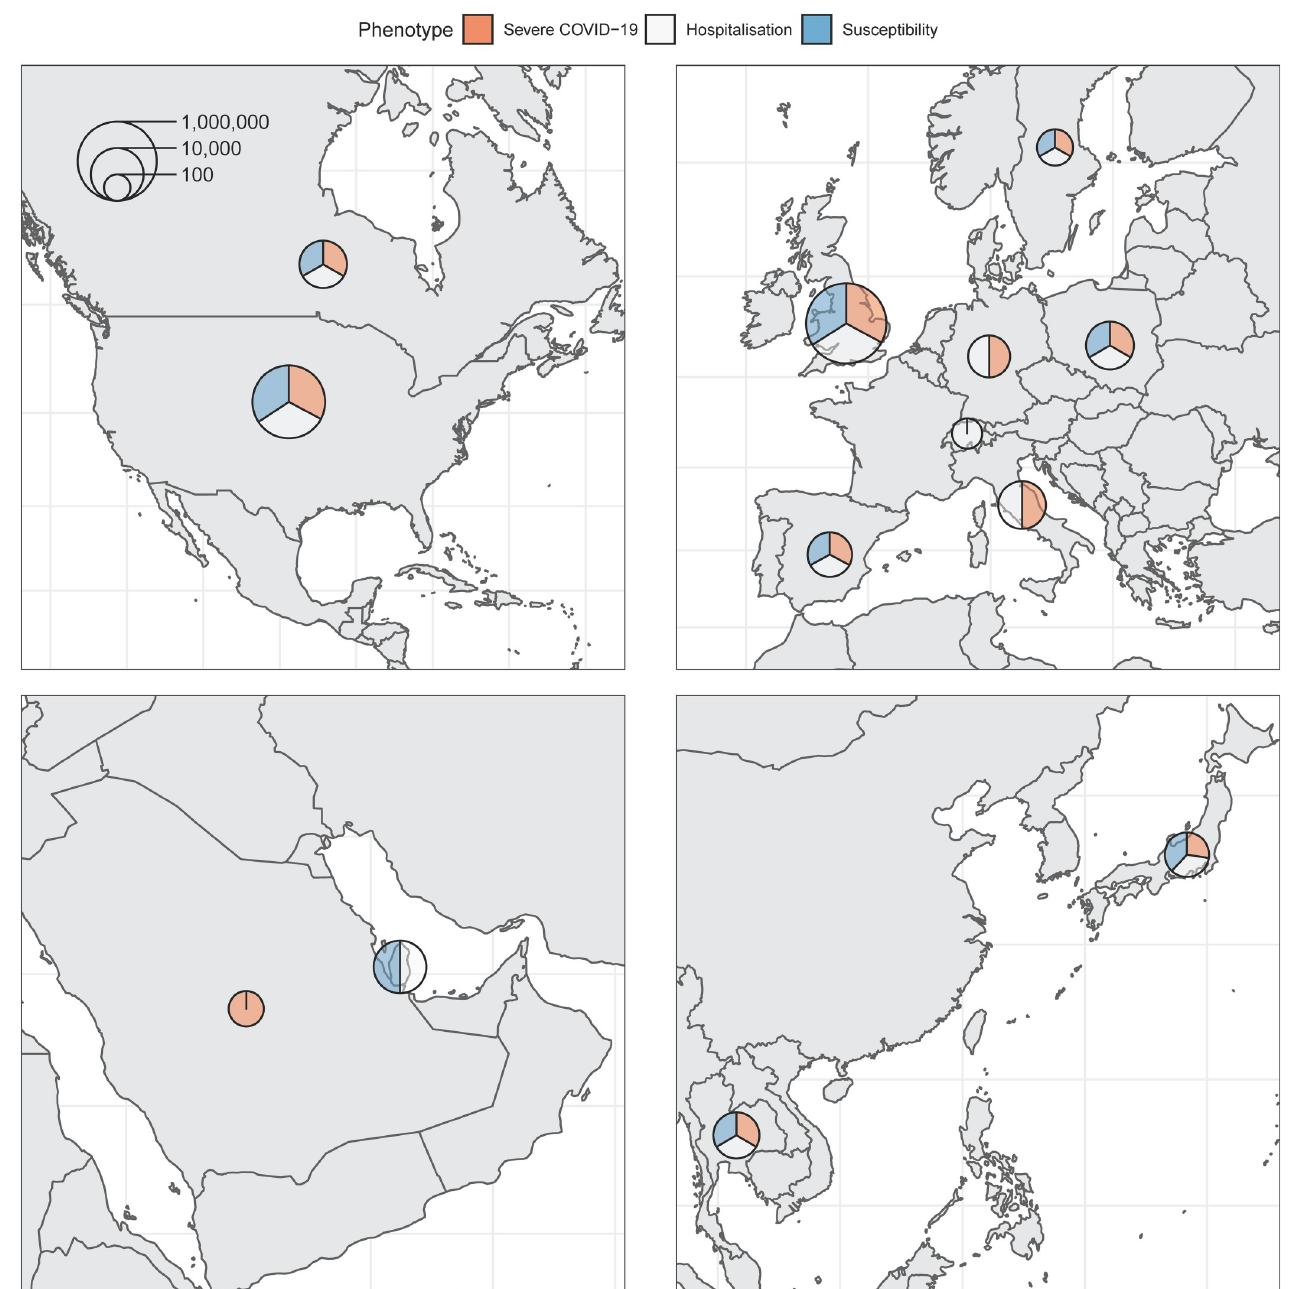
Fig 1. Maps of countries contributing data to the consortium. Sample sizes (cases and controls) for each phenotype were added and represented on the logarithmic scale by each circle. Relative contribution to each phenotype is represented by the three colors. Maps obtained from https://www.naturalearthdata.